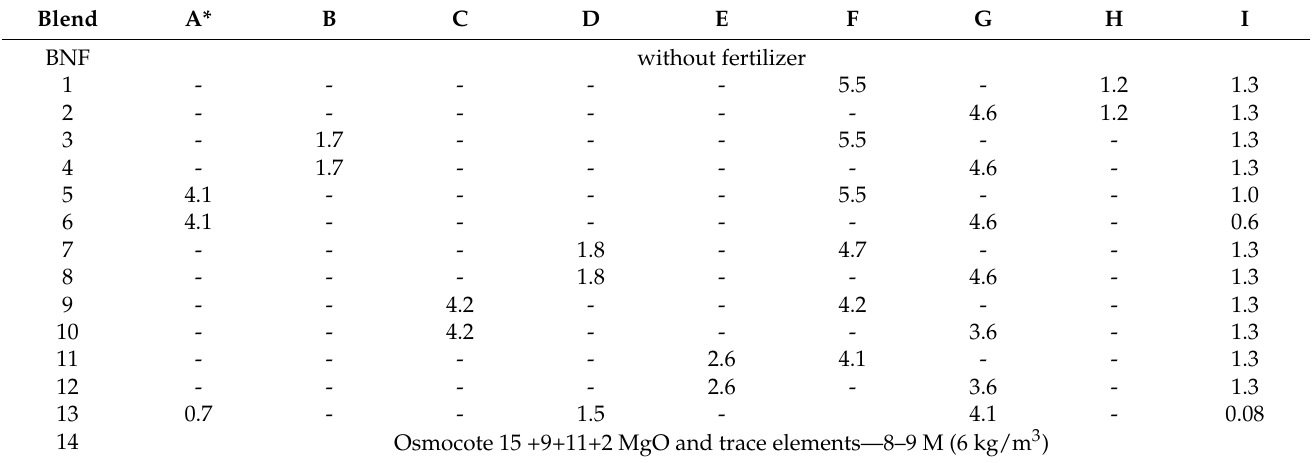
Table 2. Overview of the different amounts of recovered nutrients and standard fertilisers used for each blend (kg/m 3 for the solid materials and in mL/m 3 for the liquid materials); BNF = blank/control, containing no additional